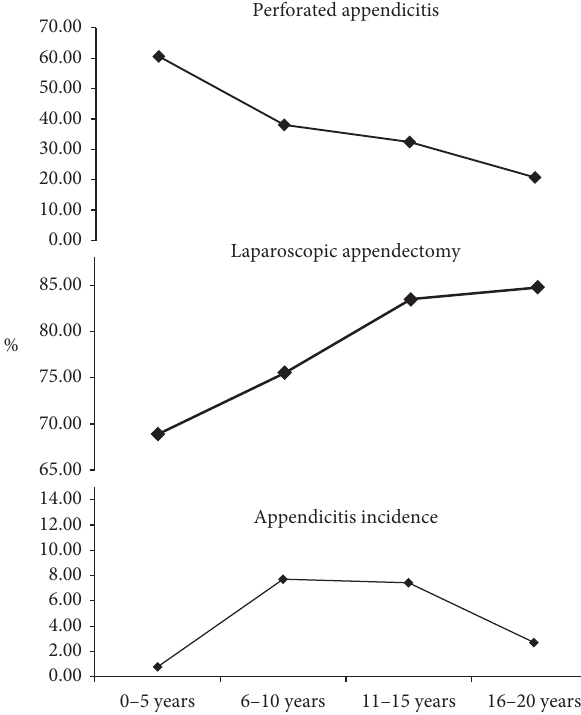
Figure 1: Age-specific trends in incidence of appendicitis, ap- pendicitis with peritonitis or abscess, and laparoscopic appen- dectomy (trend analysis; p < 0 .